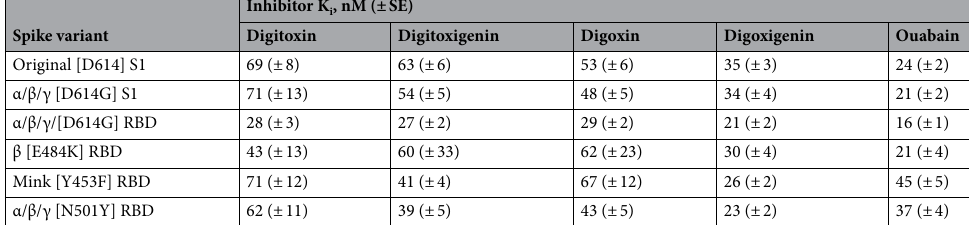
Table 2. Cardiac glycoside inhibition of ACE2 binding to SARS-CoV-2 spike variant proteins. Values are based on calculating K i values for all concentrations of ACE2 and averaging all values for the individual recombinant proteins. Each point is the average ± SE for 5–6 independent experiments.